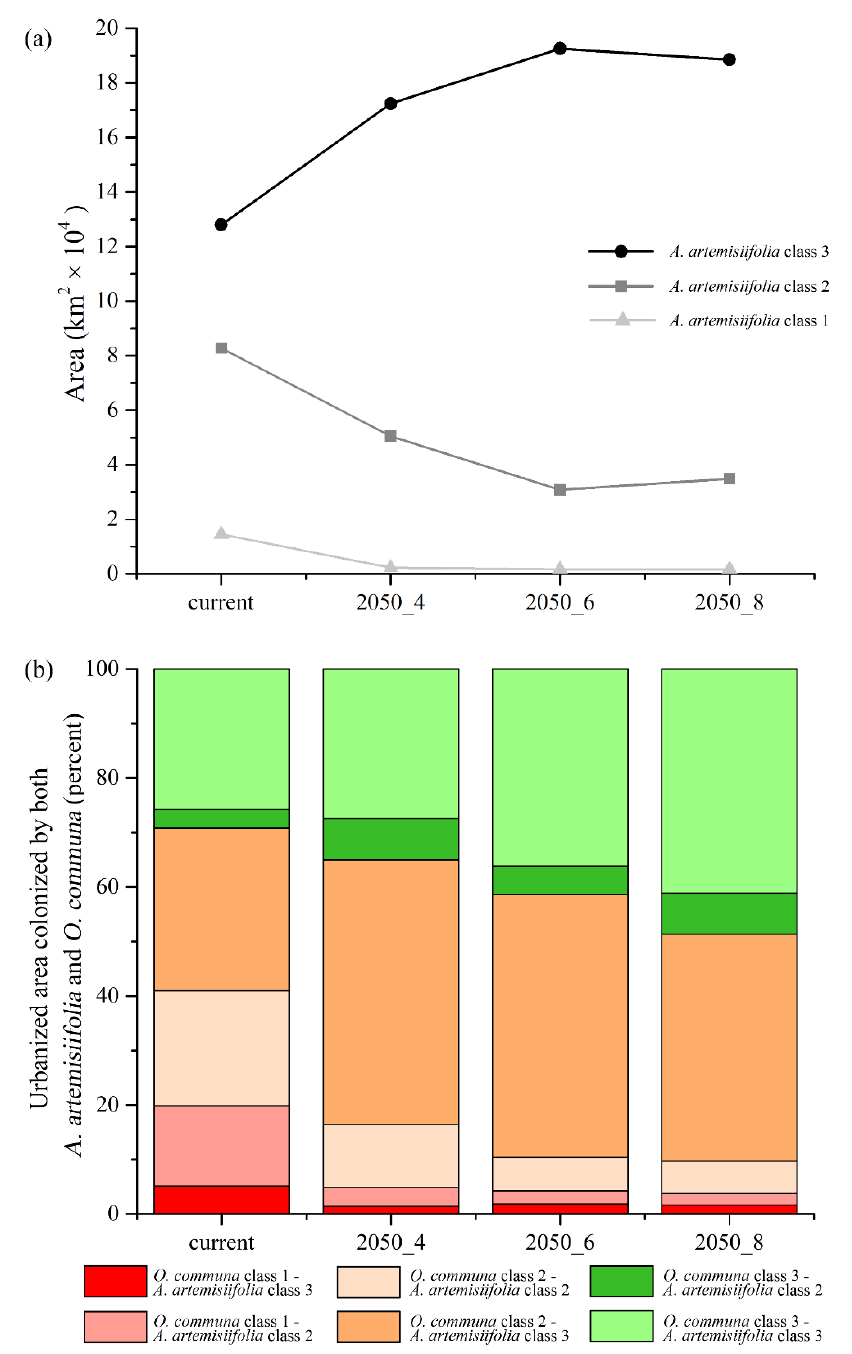
Figure 6. Trends for Ambrosia artemisiifolia and cumulative areas shared by target species in urbanized areas. Areas predicted as suitable (class 1 = low; class 2 = medium; class 3 = high) for Ambrosia artemisiifolia falling within urbanized patches in the different time frames considered ( a ); areas (percent, cumulative) potentially shared by both Ambrosia artemisiifolia and Ophraella communa for the different suitability classes (class 1 = low; class 2 = medium; class 3 = high) and time frames considered, falling within urbanized patches ( b ).